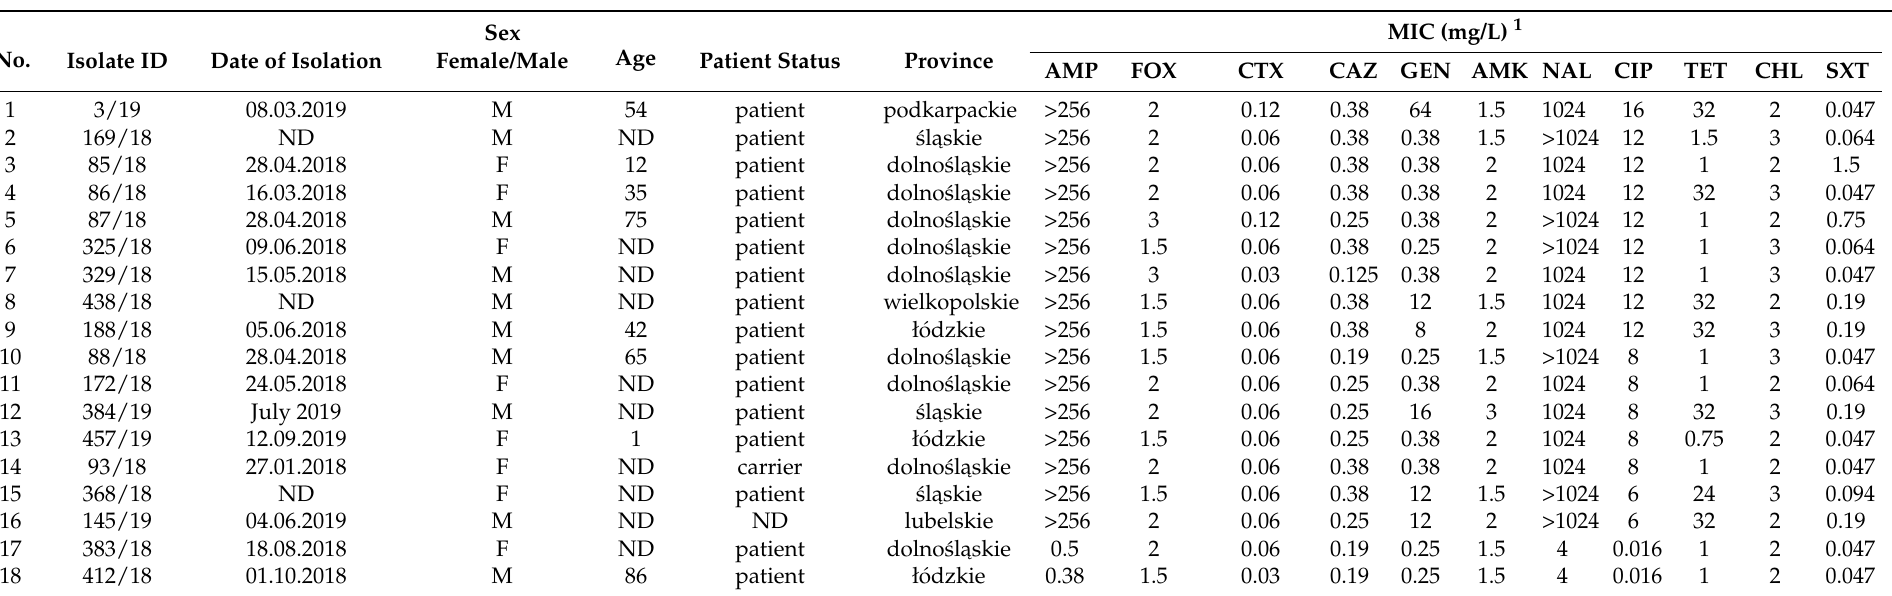
Table 1. Basic epidemiological data and antimicrobial minimum inhibitory concentrations for the 18 Salmonella Kentucky